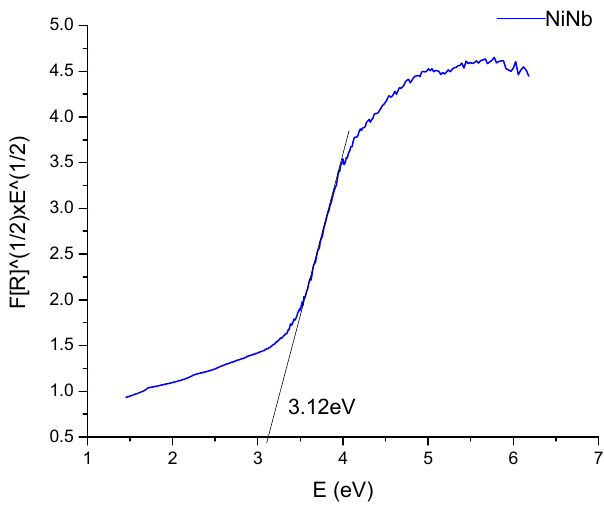
Figure 2. Result of Diffuse Reflectance Spectroscopy (DRS) analysis of the NiNb catalyst.